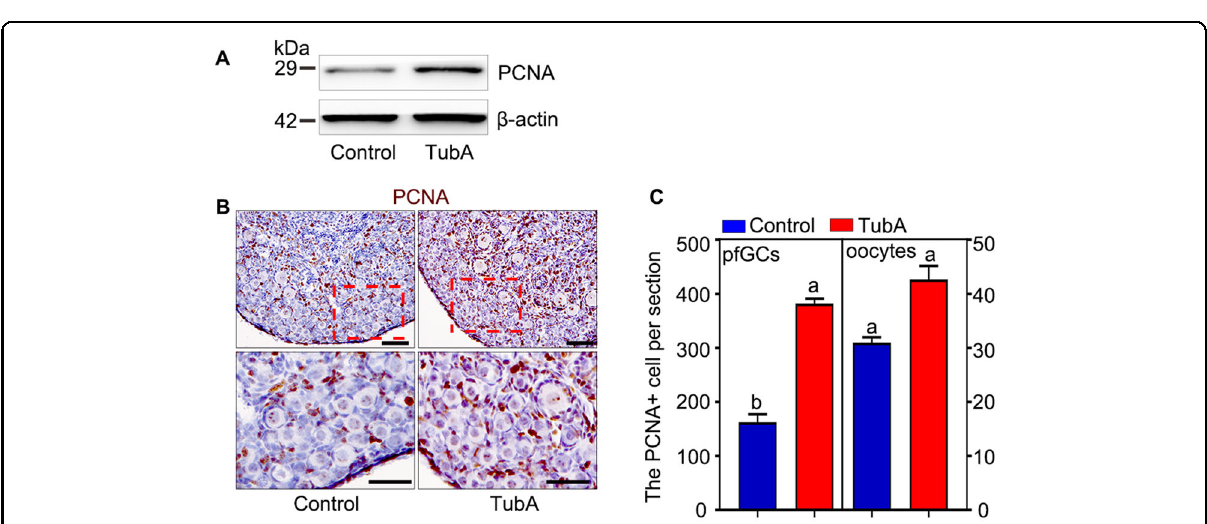
Fig. 5 HDAC6 regulates the proliferation of primordial follicle granulosa cell. A The western blotting results showed PCNA was increased after 2 dpp ovaries was cultured with TubA for 1 day. B Immunostaining stain of PCNA results showed that the growth of pfGCs in primordial follicles was increased compared with the control after 2 dpp ovaries were cultured with or without TubA for 1 day. C PCNA counting results showed that PCNA positive signaling was increased in pfGCs after with TubA compared with the control. The experiments were repeated at least three times. And representative images are shown. Scale bars: 50 μ